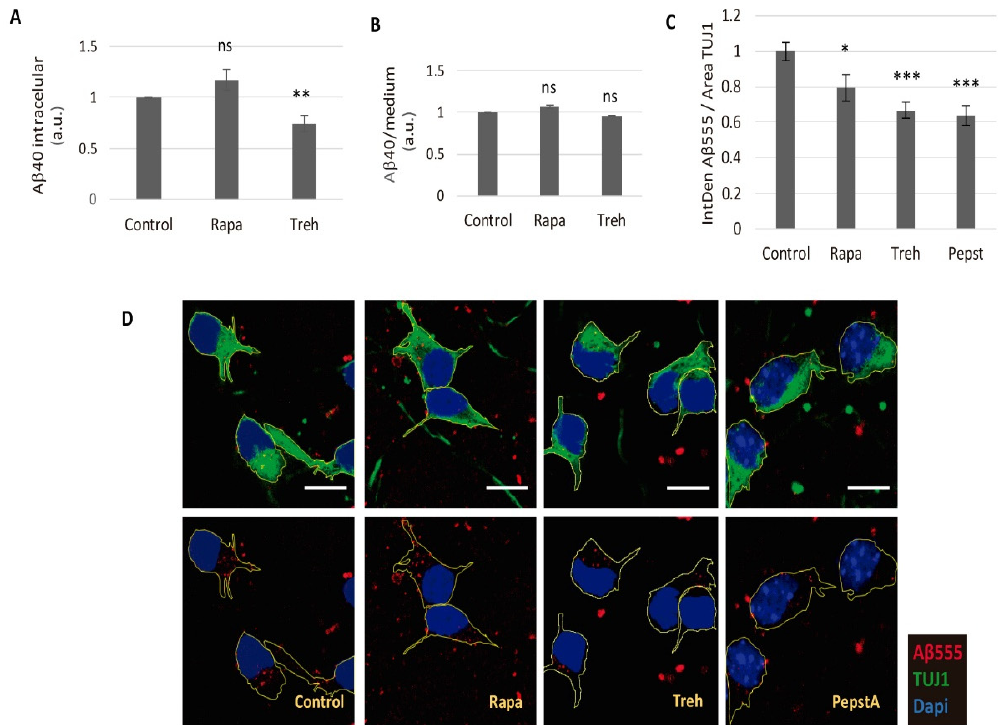
Figure 3. Trehalose did not block the secretion or endocytosis of amyloid beta peptide. The ( A ) APP/PS1 CGN cultures were treated with 100 mM of trehalose (Treh) or 200 nM of rapamycin (Rapa) and intracellular A β 40 levels in cell extracts were detected by ELISA. Student’s t-test was performed ( n = 6). The ( B ) CGN cultures from wild-type mice were treated for 48 h with 100 mM of Treh or 200 nM of Rapa in conditioned media from cultured APP/PS1 CGN. The remaining A β 40 levels in culture media were detected by ELISA. One-way ANOVA was performed (n = 3). The ( C , D ) CGN cultures from wild-type mice were treated for 4 h with 100 mM of Treh, 200 nM -of Rapa or 10 μ g/mL of pepstatin A in the presence of 2 μ g/mL HiLyte™ Fluor 555 labeled-A β (1-40) (A β 555), and the internalized A β 555 was measured by confocal microscopy. The ( C ) quantification of A β 555 intensity in relation to the neuronal area; and ( D ) representative images: A β 555 (red), TUJ1 (green), and dapi (blue). Forty-five neurons were quantified per experimental condition. (ns: non-significant; * p ≤ 0.05; ** p ≤ 0.01; and *** p ≤ 0.001). Bars represent mean ± SEM.